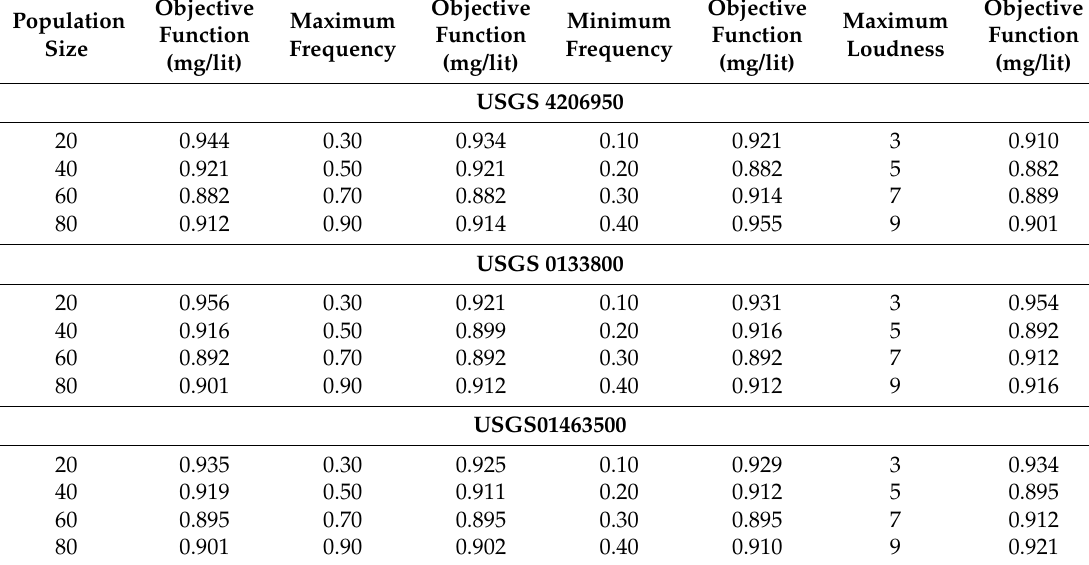
Table 5. The sensitivity of the parameters of the bat algorithm at the three investigated water quality monitoring